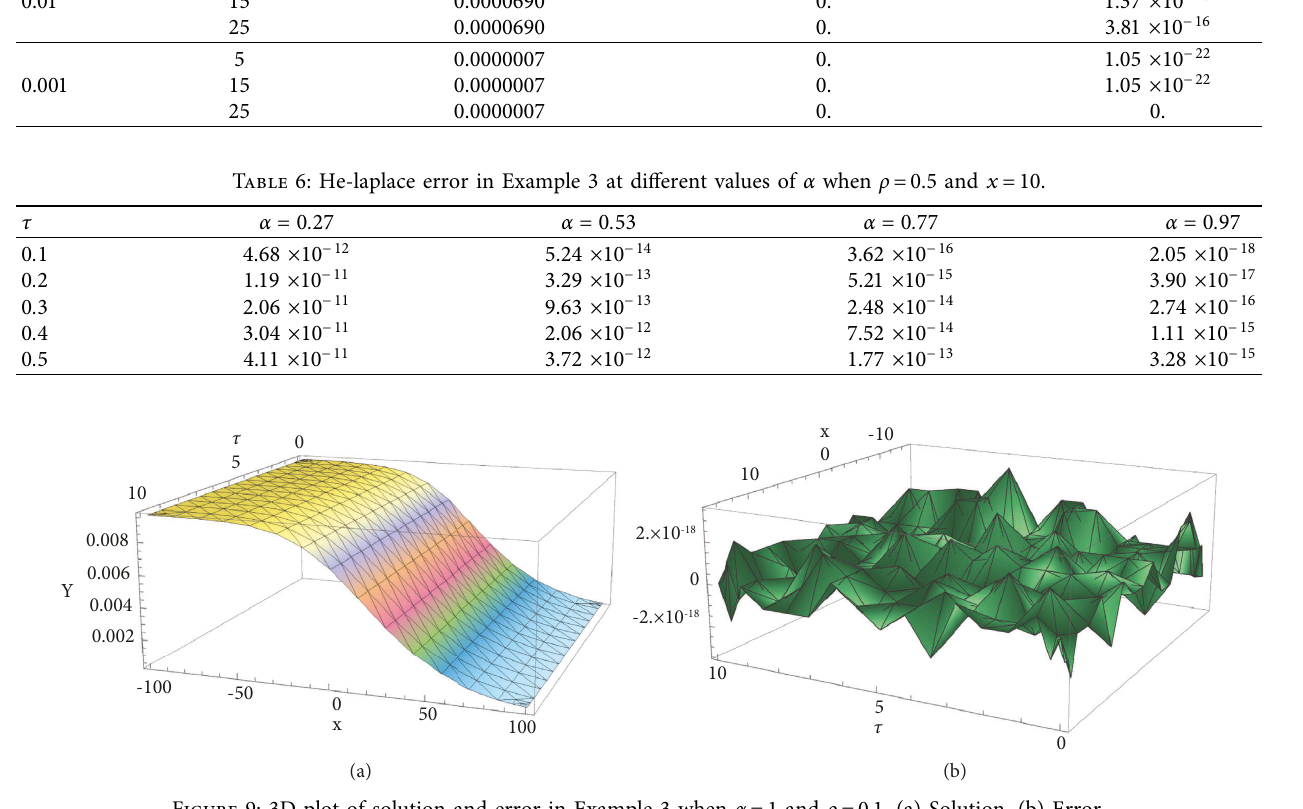
Figure 9: 3D plot of solution and error in Example 3 when α � 1 and ρ � 0.1. (a) Solution. (b)